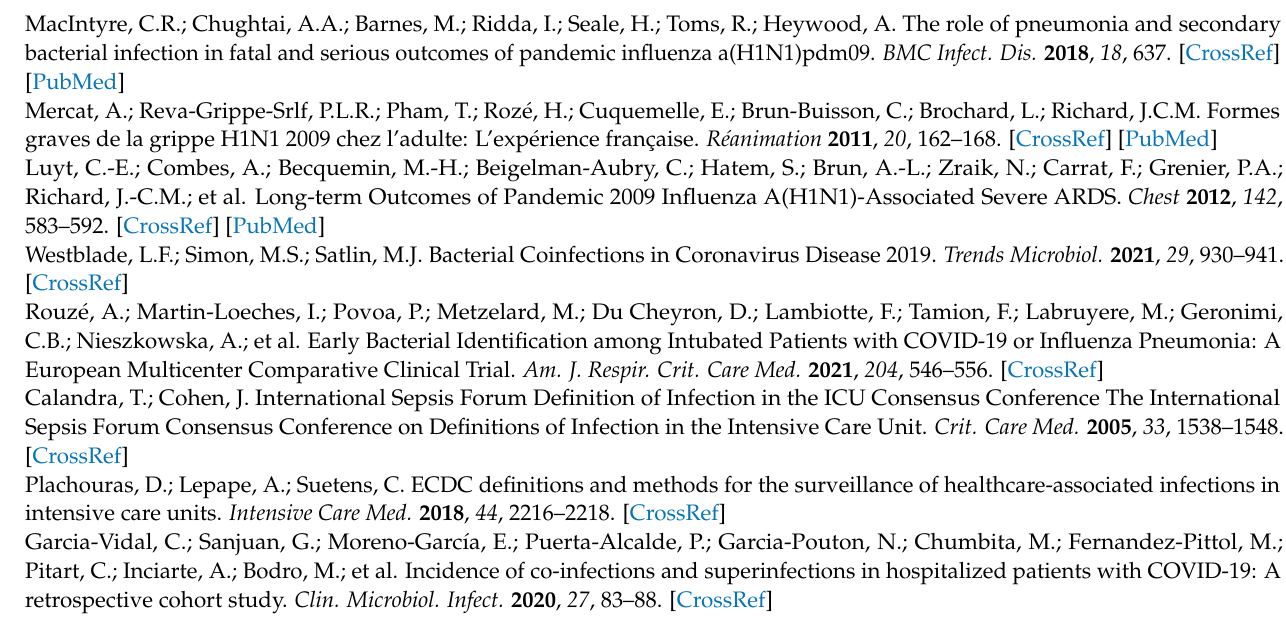
Table S2: Comparison of living and deceased patients in influenza and/or SARS-CoV2 pneumonia at D60; Table S3: Impact of Co-infection on the risk of mortality at D60, multivariate Cox model— global and per-viruses analyses according to to patients’ subgroups; Table S4: Risk factors for VAP, univariate analysis, Fine-Gray subdistribution hazard model; Table S5: Impact of co-infection on the risk of subsequent VAP among the patients at risk of VAP—multivariate survival analysis; Table S6: Risk factors for co-infection, univariate analysis, logistic